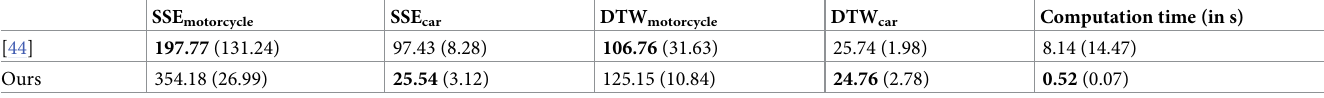
Table 12. Mean metrics computed for the Tay Son site. In parenthesis, the standard deviation. SSE motorcycle